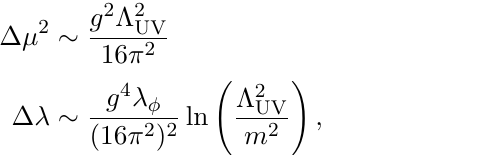
term is included. φ